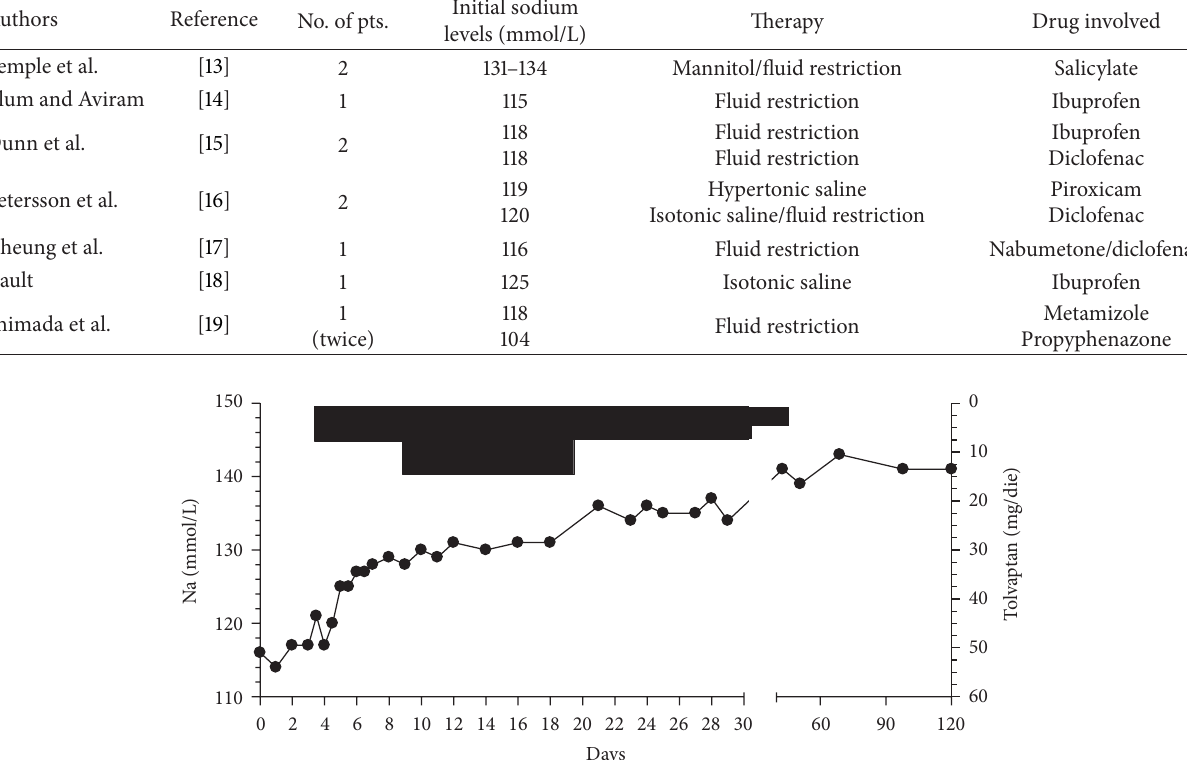
Table 1: Published cases of NSAID-induced SIADH.